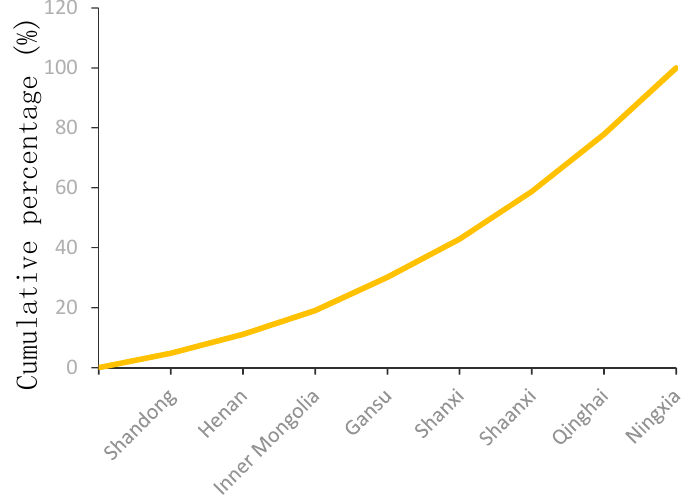
Land 2021 , 10 , 849 Figure 2. Lorenz curve of key rural tourism villages in the Yellow River Basin.